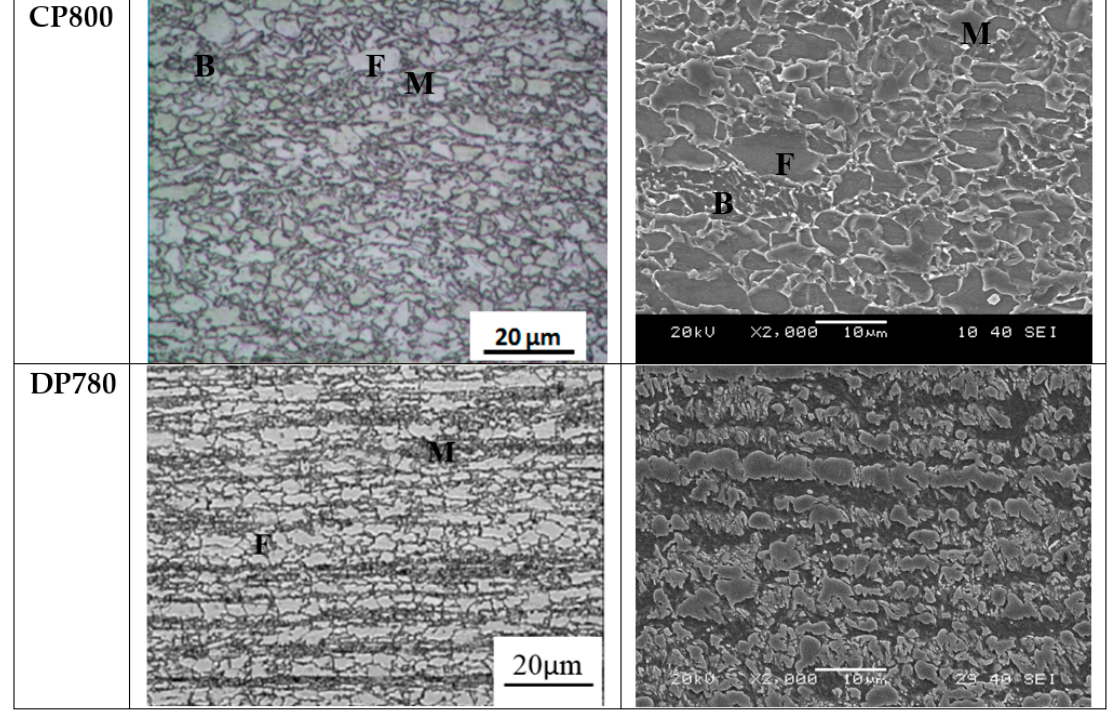
Figure 2. Optical and scanning electron microscopy (SEM) micrographs of the CP800 and DP780 with martensite ( M ), bainite ( B ), and ferrite ( F ) microstructures indicated.